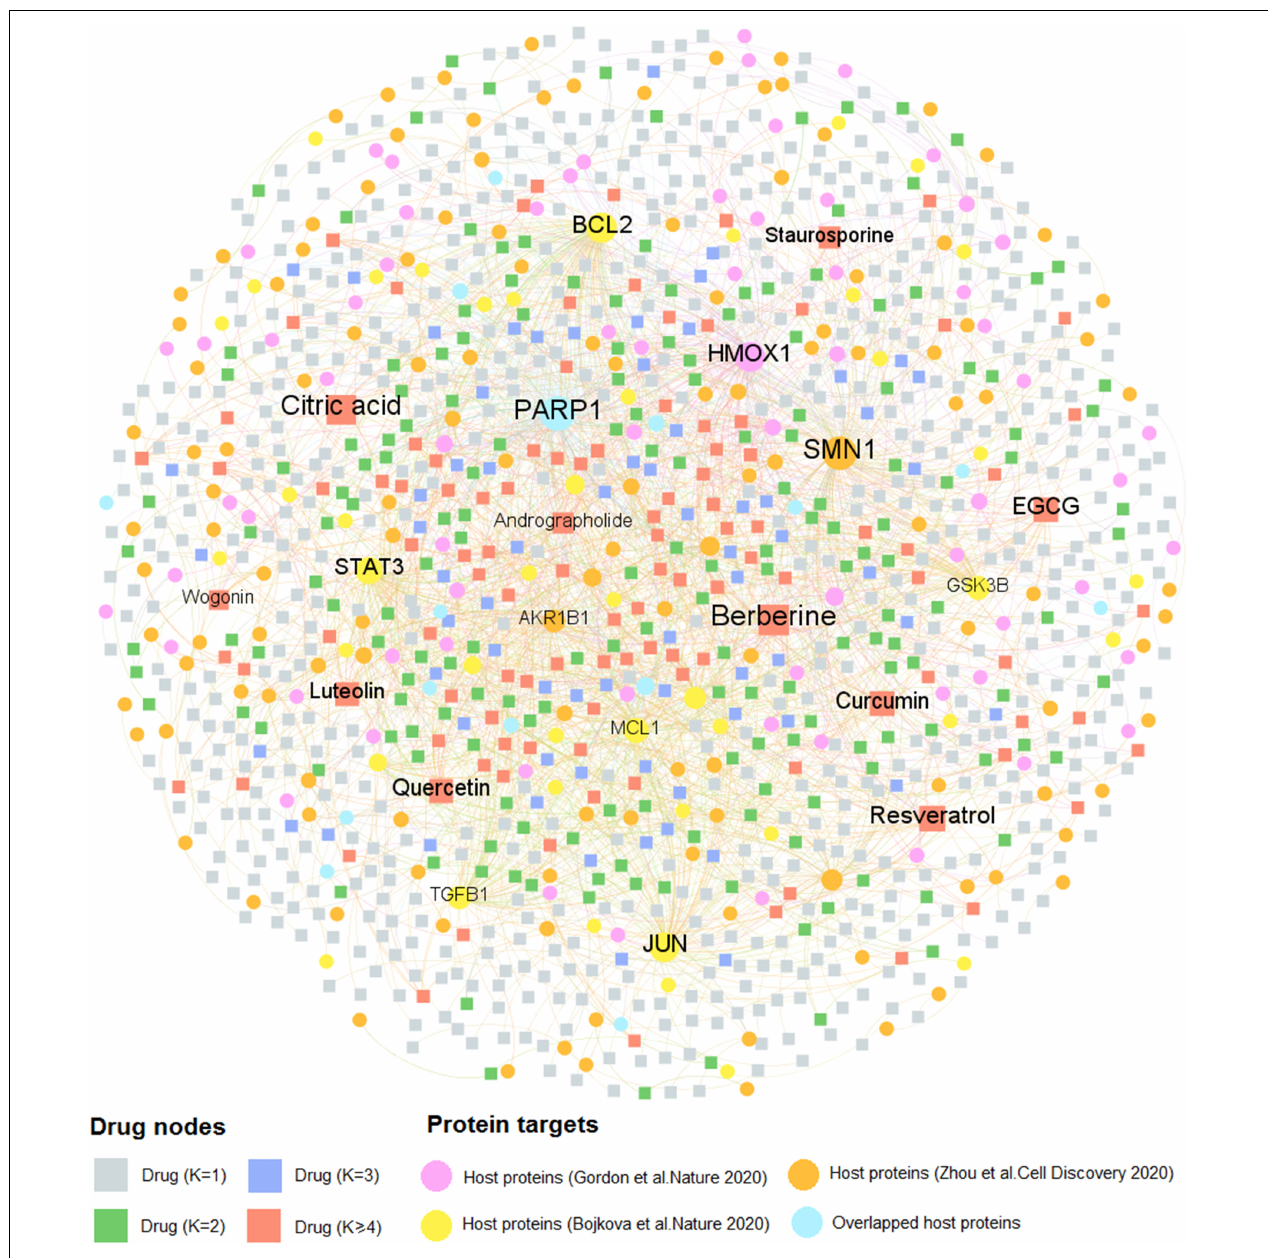
FIGURE 4 | A bipartite compound–protein network for natural products. This network comprises 2,002 interactions covering 997 natural products with 259 human host proteins. The dot stands for the host protein target while the square node represents the natural product. The label font size and node size are proportional to degree (connectivity). Only labels of the top 10 natural products and proteins with the highest degree are